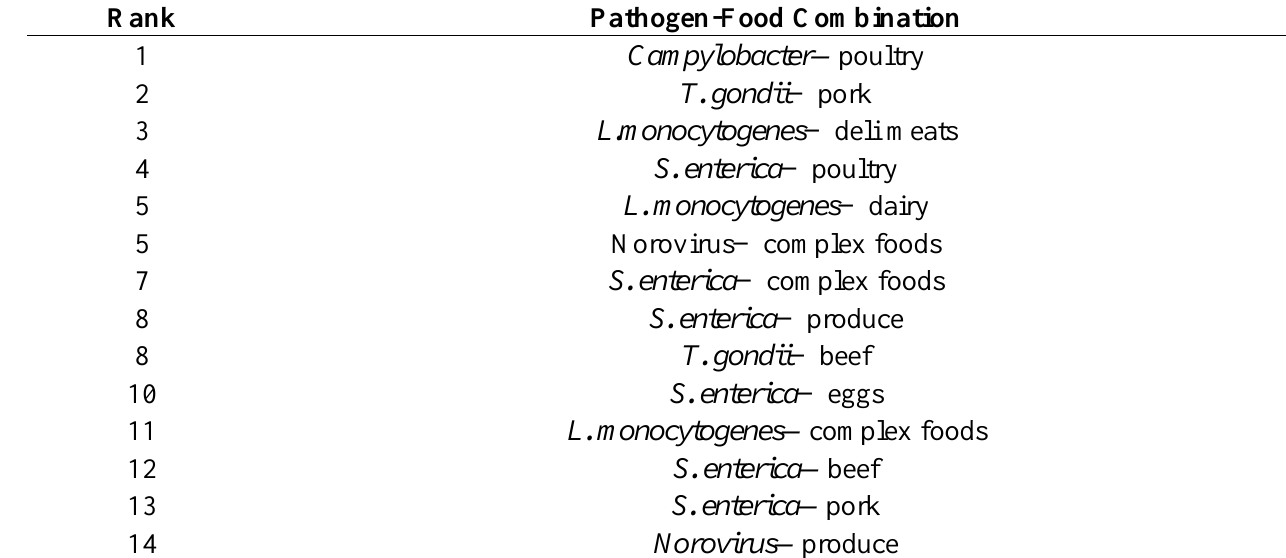
Table 6. Top fourteen pathogen-food combinations in the USA estimated by annual disease burden. Data from [15].